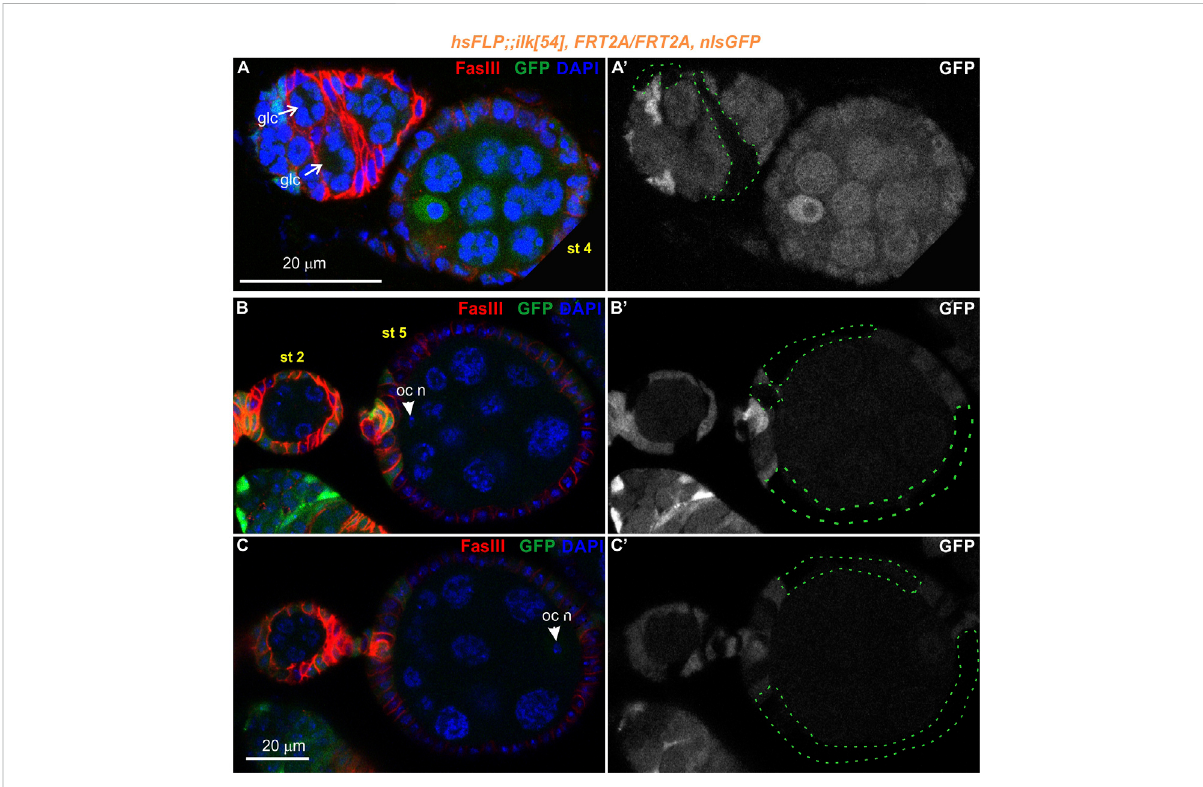
FIGURE 8 Genetic mosaics for Ilk display germline cyst encapsulation defects resulting in compound egg chambers. (A – C) Confocal micrographs of egg chambers carrying Ilk mutant clones were generated by hsFLP and marked by the absence of the nlsGFP. The presence of the mutant clones are highlightedwithagreendashedline.Co-stainingwithanti-FasIIIlabelstheperipheryoffollicleepithelialcells. (A-A 9 ) Apairofgermlinecystsinregion 2b of the germarium surrounded by Ilk mutant cells. (B,C) . Different optical sections of the same egg chambers reveal the compound egg chamber at stage 5, which contains two individual oocyte nuclei. (B-B 9 ) An oocyte nucleus is located in the anterior end of the compound egg chamber. (C-C 9 ) The second oocyte nucleus is located in the opposing posterior end of the same compound egg chamber. glc, germline cyst; oc n, oocyte nucleus. Scale bars: 20 μ m in all